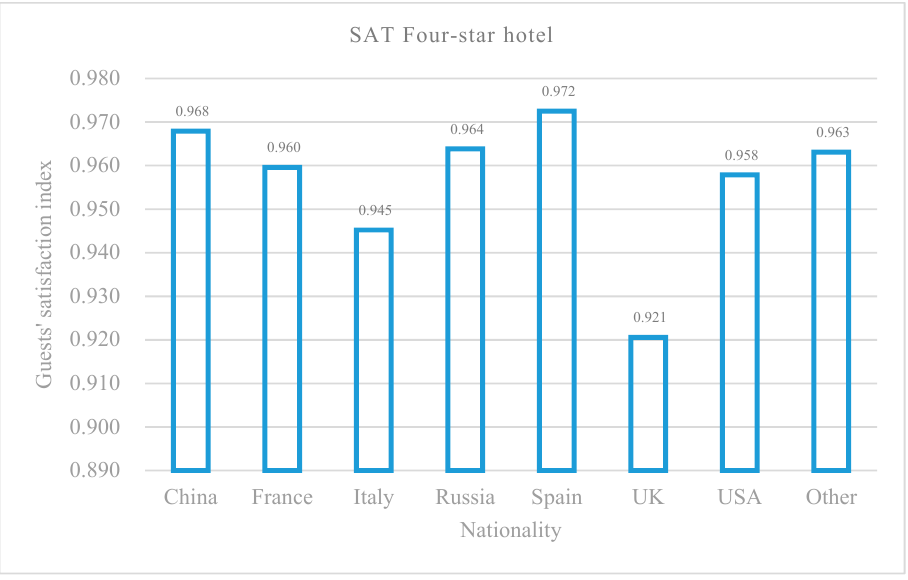
Figure 2. Guests’ satisfaction index by nationality in the four-star hotel.